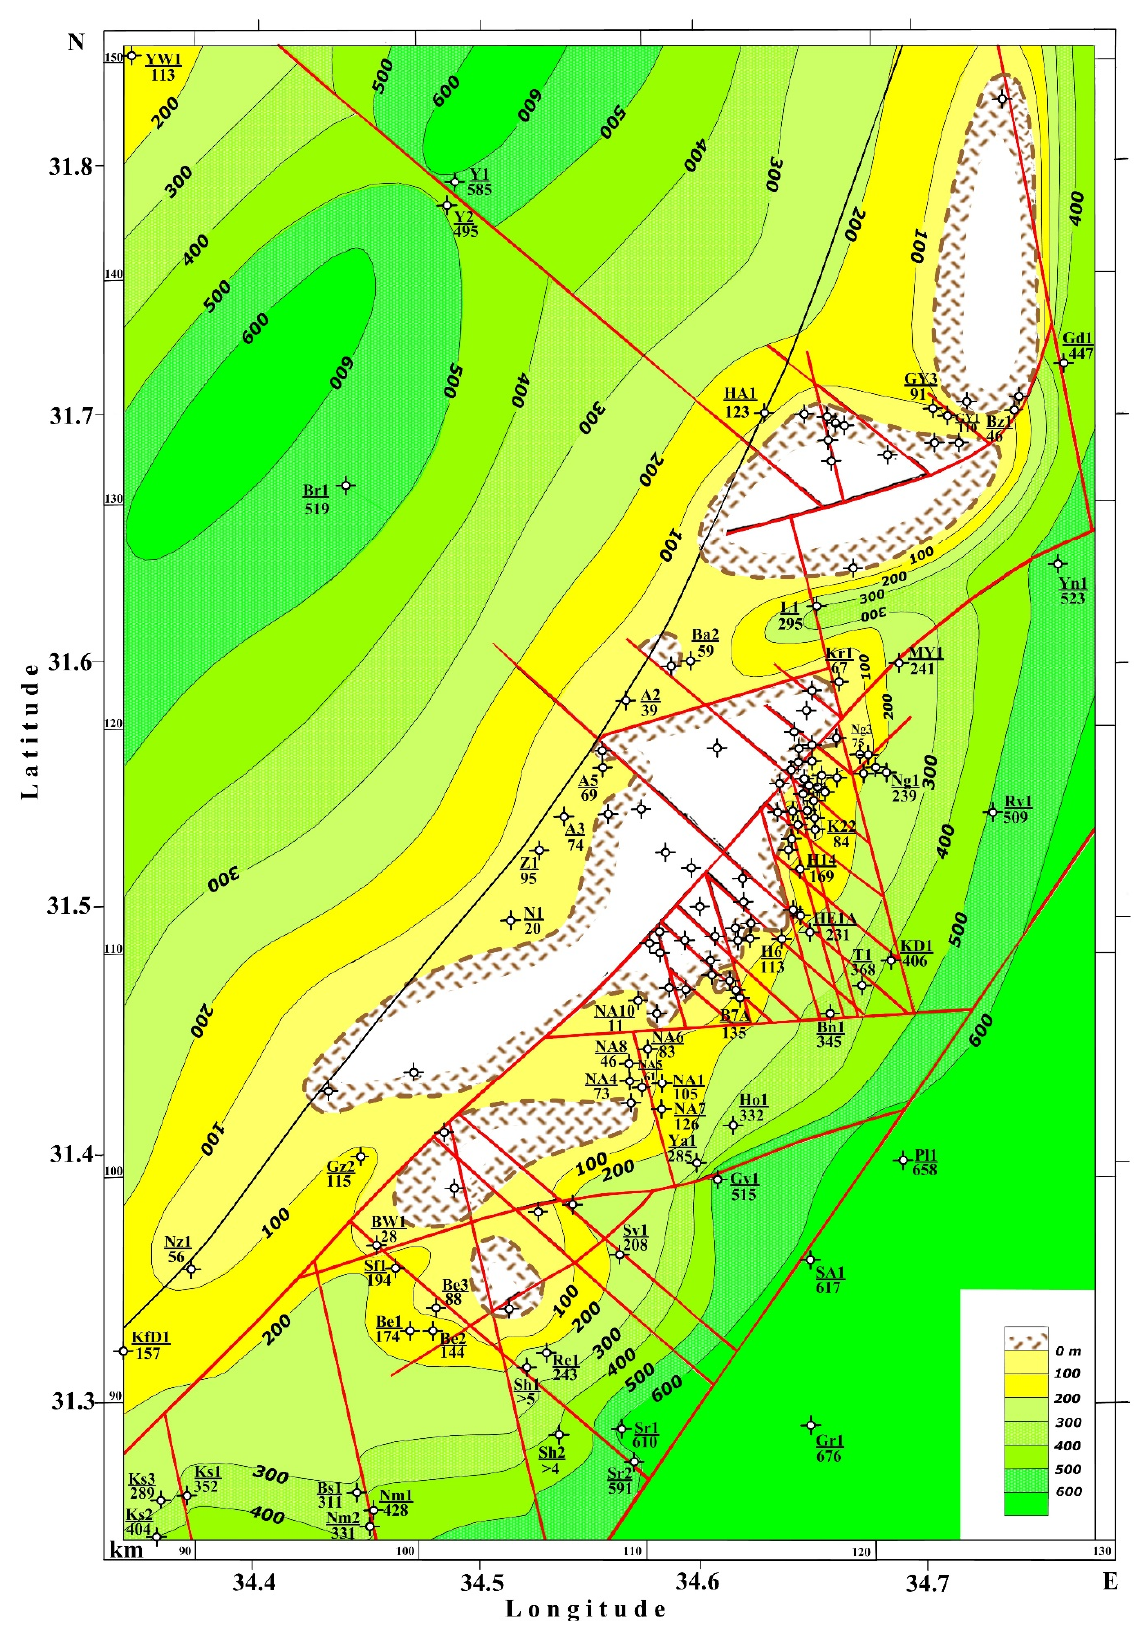
Figure 4. Late Cretaceous structural–paleogeographic map of the Heletz–Ashdod oil field and adjacent areas. Borehole abbreviations: see captions for Figure 2.